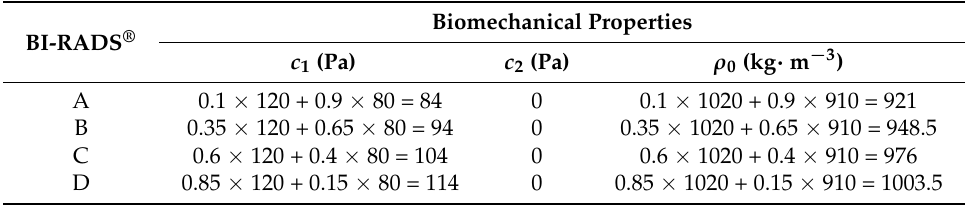
Table 2. Combination of tissues biomechanical properties for each density category. c 1 and c 2 are parameters of the Mooney-Rivlin biomechanical model, and ρ 0 is the material density. The reference values from Vavourakis et al. [24] were